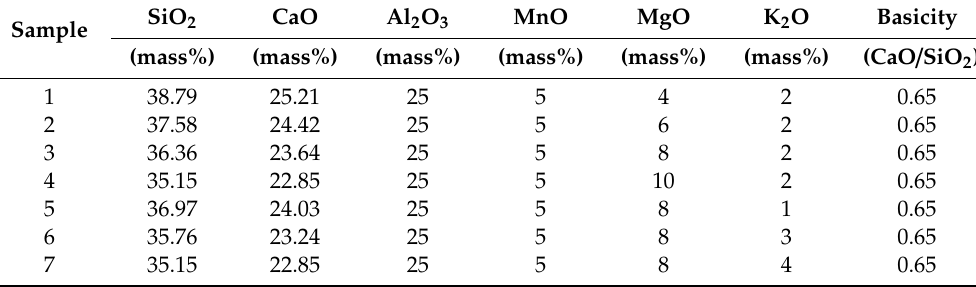
Table 2. The intended composition of the synthesized sample.